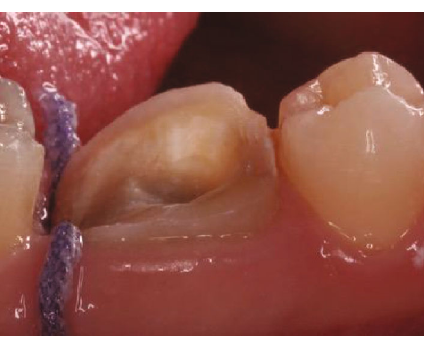
Figure 2: After preparation with placed retractor cord before